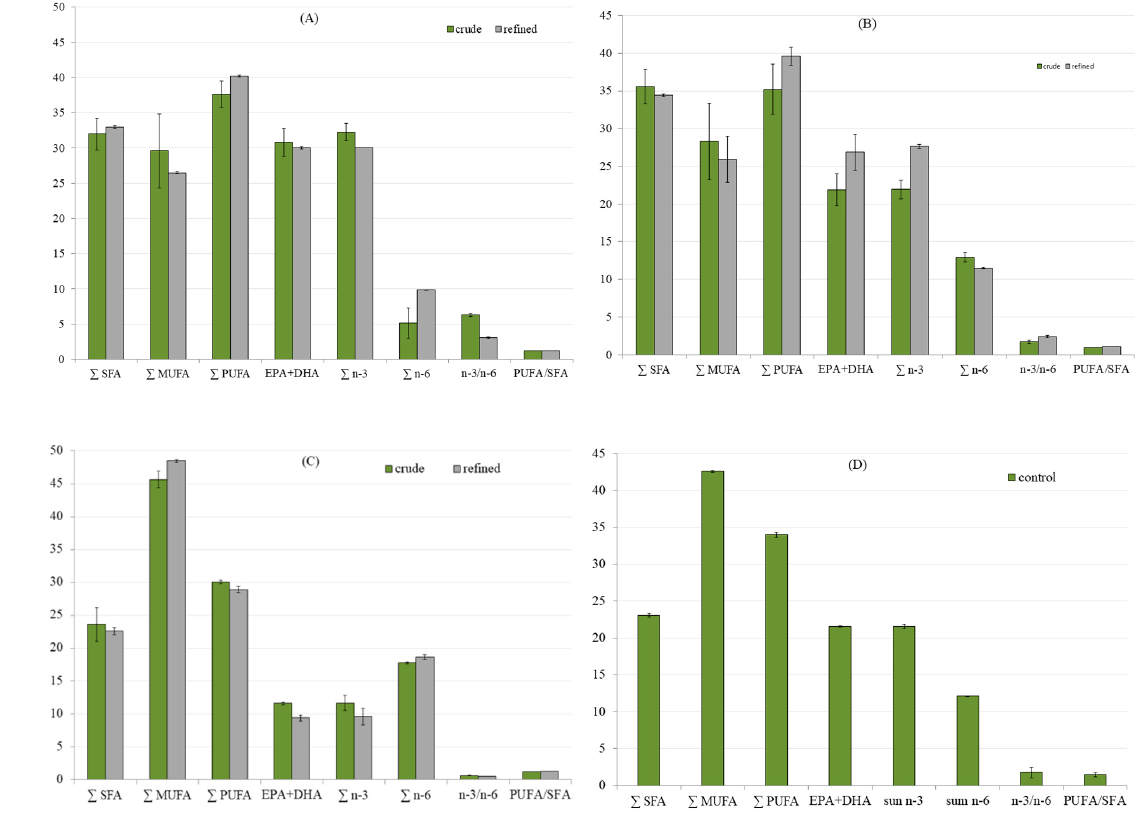
Figure 2. The sum of monounsaturated ( ∑ MUFA) and polyunsaturated ( ∑ PUFA) fatty acids, the sum of eicosapentaenoic and docosahexaenoic fatty acids (EPA + DHA), the sum of n-3 and n-6 content plus ratios between n-6/n-3 and polyunsaturated fatty acids/saturated fatty acids (PUFA/SFA) in crude and refined oils from: ( A ) tuna by-products, ( B ) tuna liver, ( C ) seabass and gilthead seabream by-products and ( D ) cod liver oil (control).